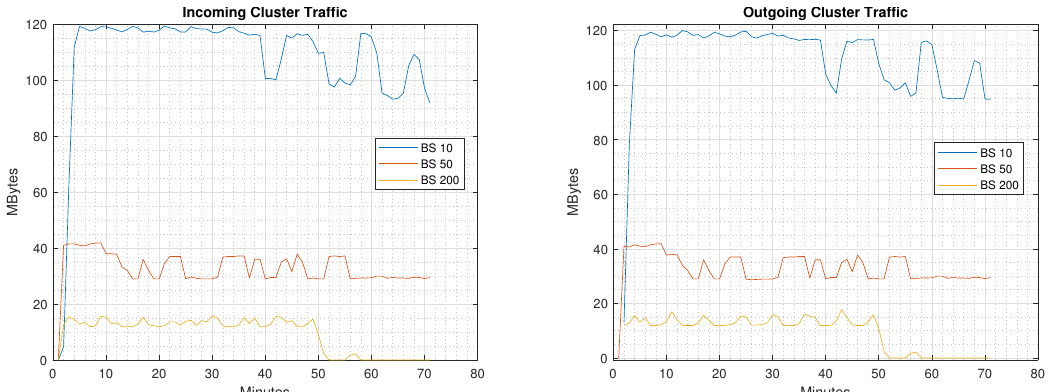
Figure 10. Incoming and Outgoing cluster traffic of the baseline architecture for different Batch Sizes.